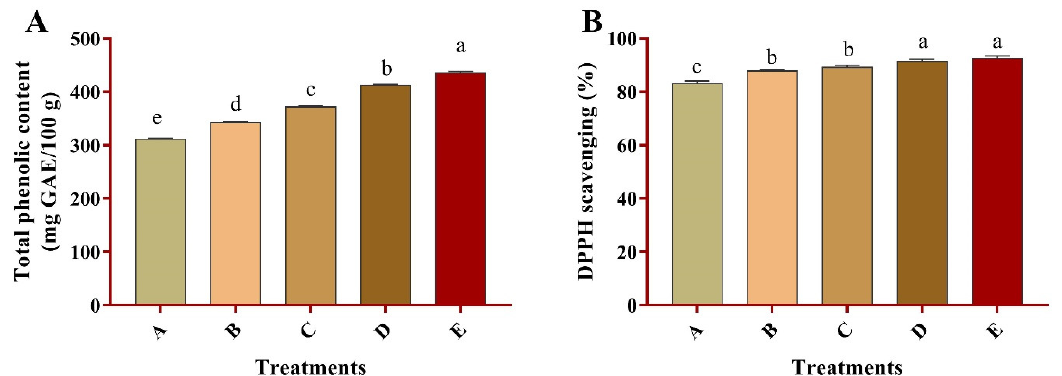
Figure 2. Total phenolic content ( A ), antioxidant activity (DPPH scavenging, ( B )), of date jam prepared with different amounts of powdered date press cake. Values are expressed as the means ± standard deviation. Columns bearing with different superscript letters are significantly different ( p < 0.05). A: 0% DPC; B: 3% DPC; C: 6% DPC; D: 9% DPC; E: 12% DPC.